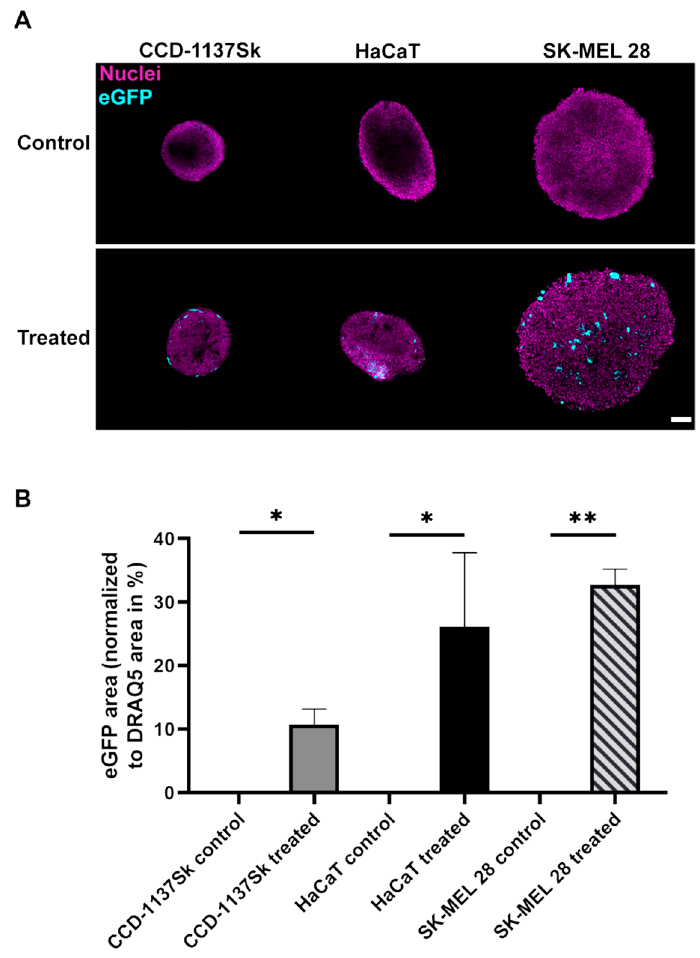
Figure 3. SK-MEL 28 spheroids show high expression of eGFP upon eGFP LPX transfection. For each spheroid, a total of 1 × 10 4 cells was seeded and transfected with 10 ng/ µ L eGFP LPX. Control, PBS only. Confocal microscopy was used to visualize nuclei (magenta) and eGFP (cyan). ( A ) Representative single confocal sections in the center of representative spheroids are shown. Scale bar, 100 µ m. ( B ) Quantitative analysis of the eGFP area normalized to nuclei signal area is depicted. Mean + SD ( n = 3 independent experiments, at least 3 spheroids per condition). One-way ANOVA with Tukey’s multiple comparison post hoc test ( α = 0.05). * p ≤ 0.05, ** p ≤